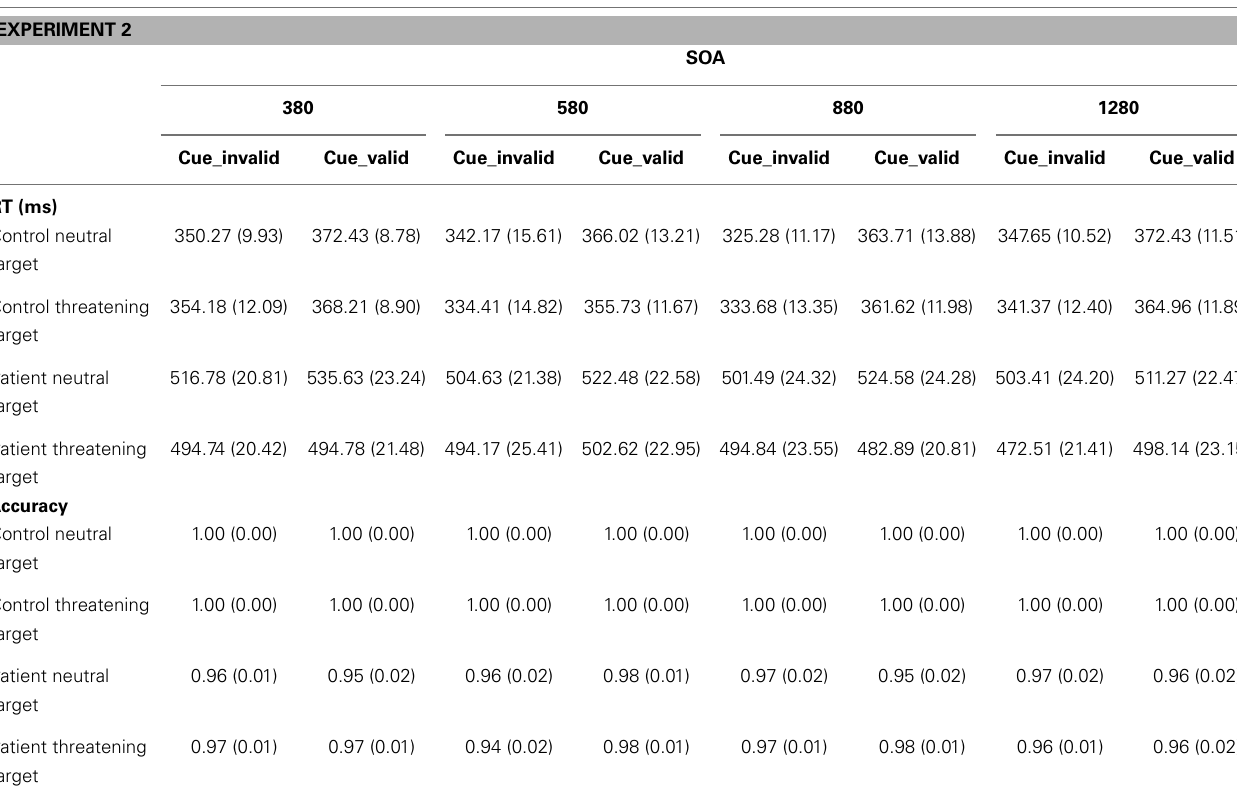
Table 4 | Mean reaction times (ms) and accuracy as a function of target valence (threatening vs. neutral), Cueing (valid vs. invalid), and SOA in Experiment 2.